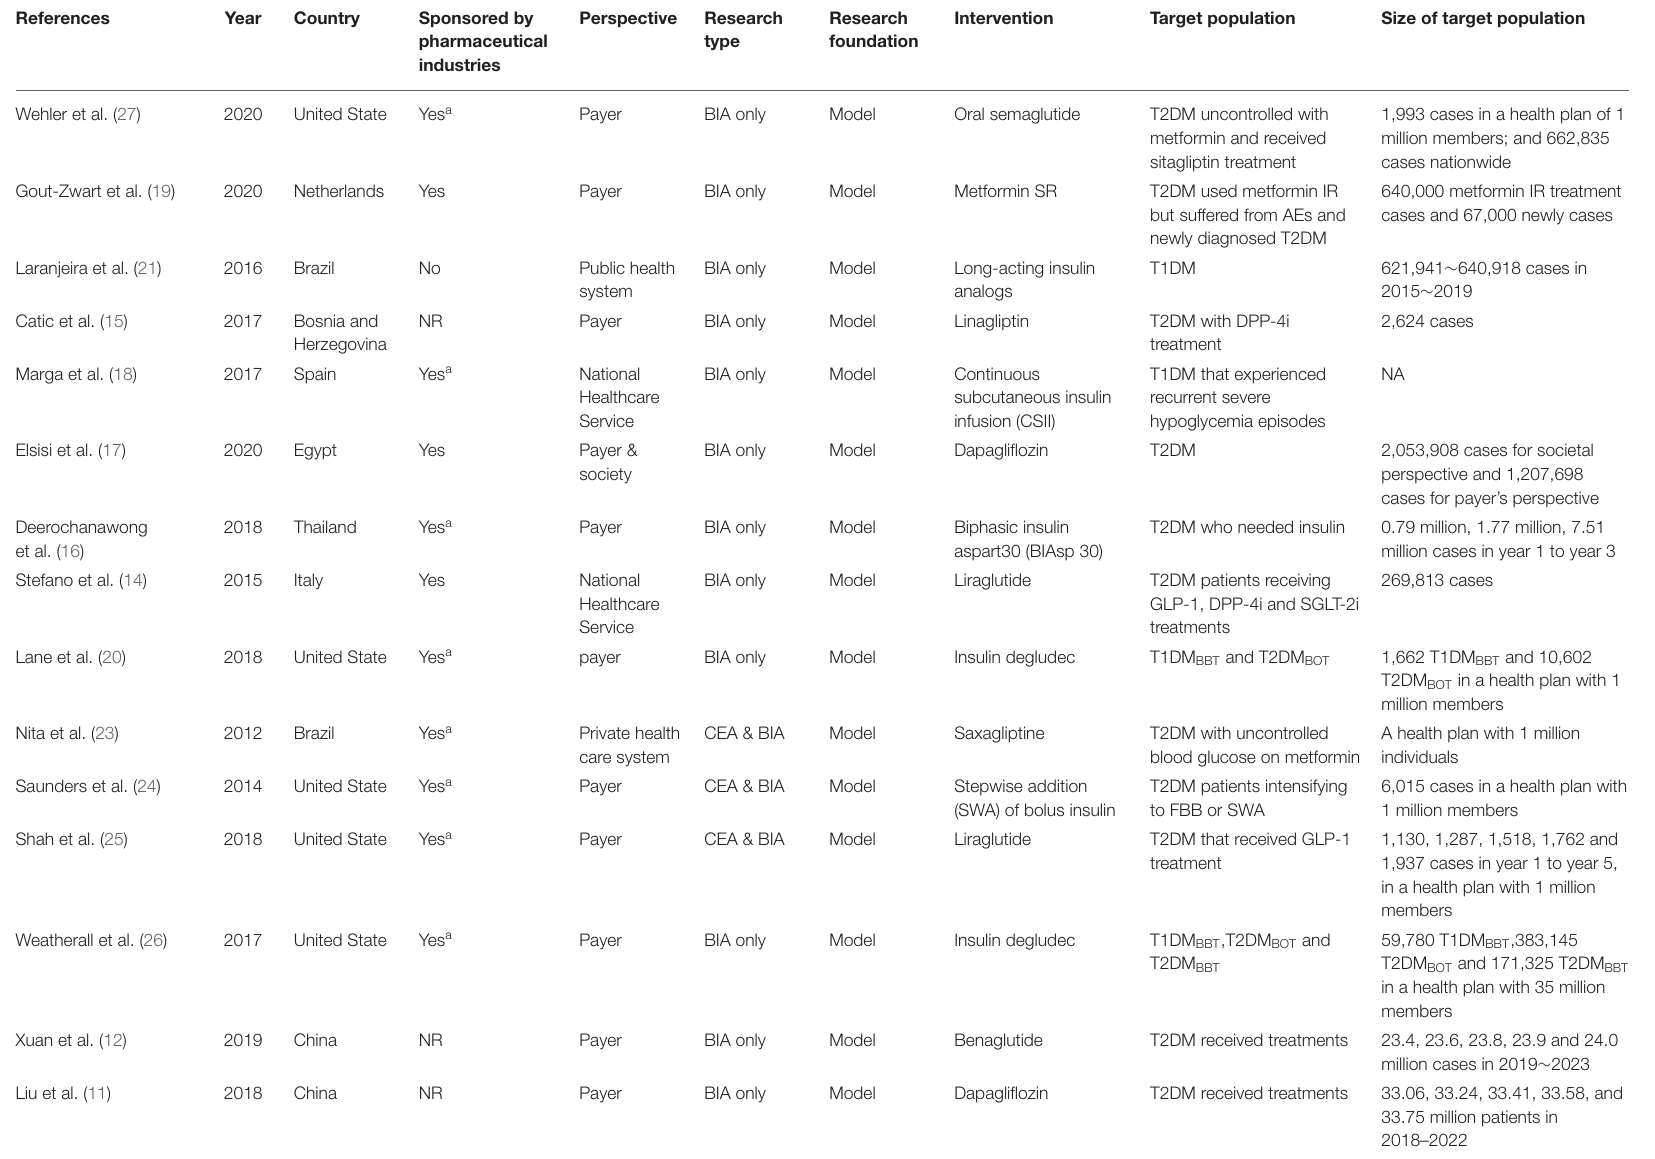
TABLE 1 | General information of the included